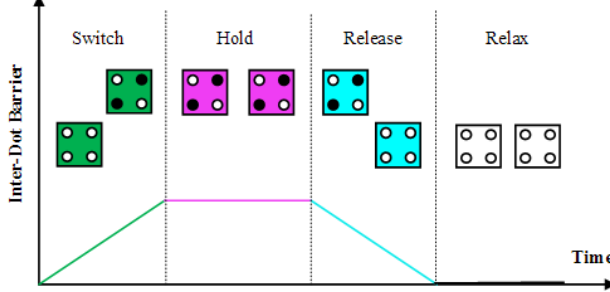
Figure 4. Clocking zones in QCA [1,26] .